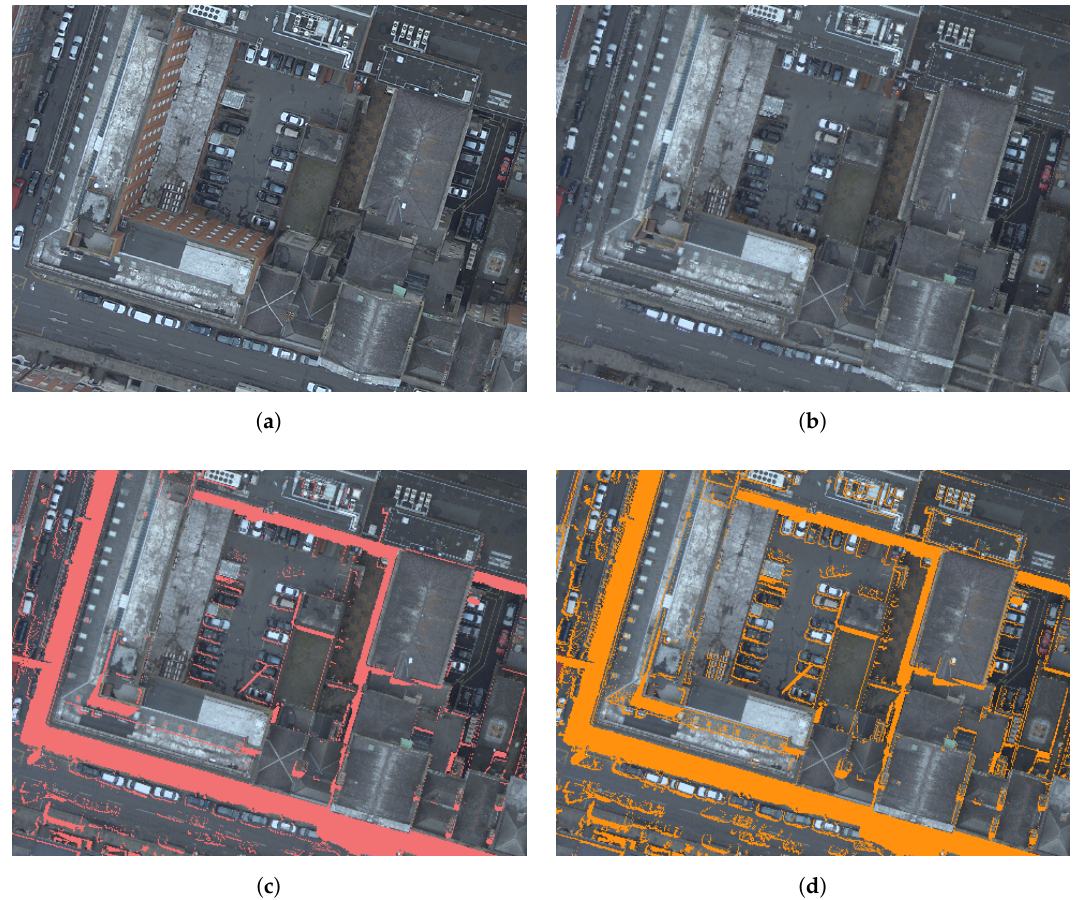
Figure 18. Detected occlusions using the height-based and angle-based techniques: ( a ) Perspective image, ( b ) Differentially-rectified orthophoto, ( c ) Detected occlusions using the height-based method, and ( d ) Detected occlusions using the angle-based technique. Pixel size is 10 cm in the